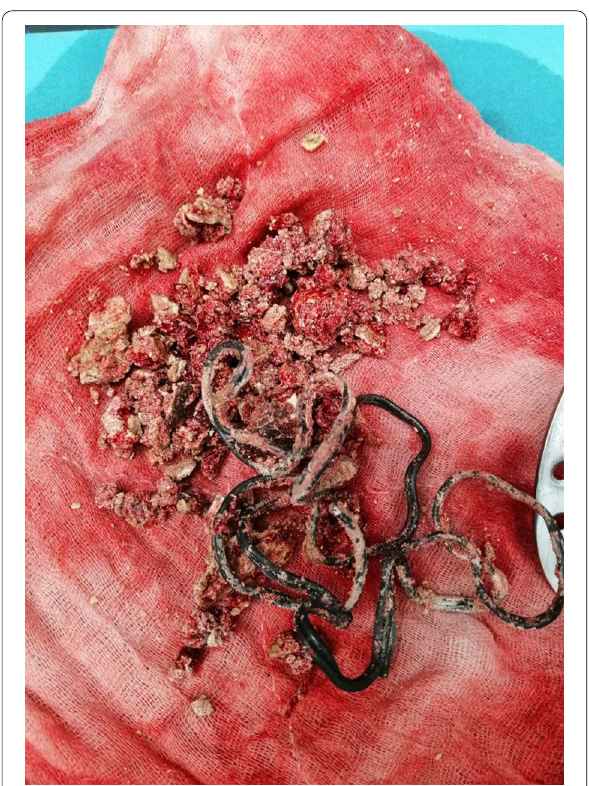
Fig. 2 Electric wire intertwined with bladder